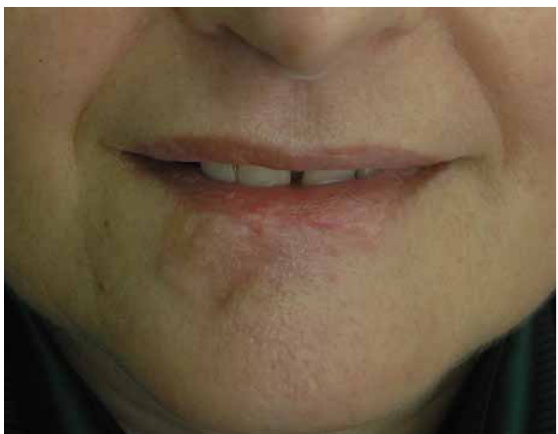
Figure 3c. Six months after treatment